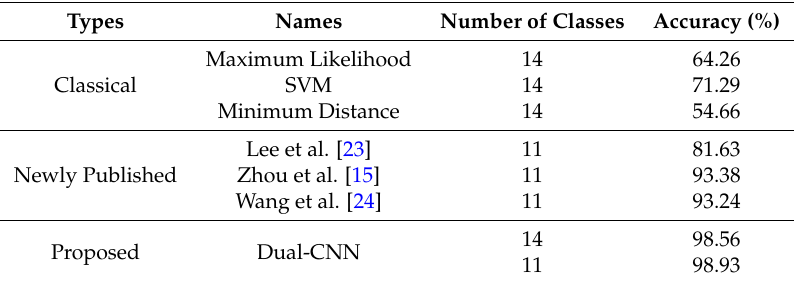
Table 3. Comparison of results with other